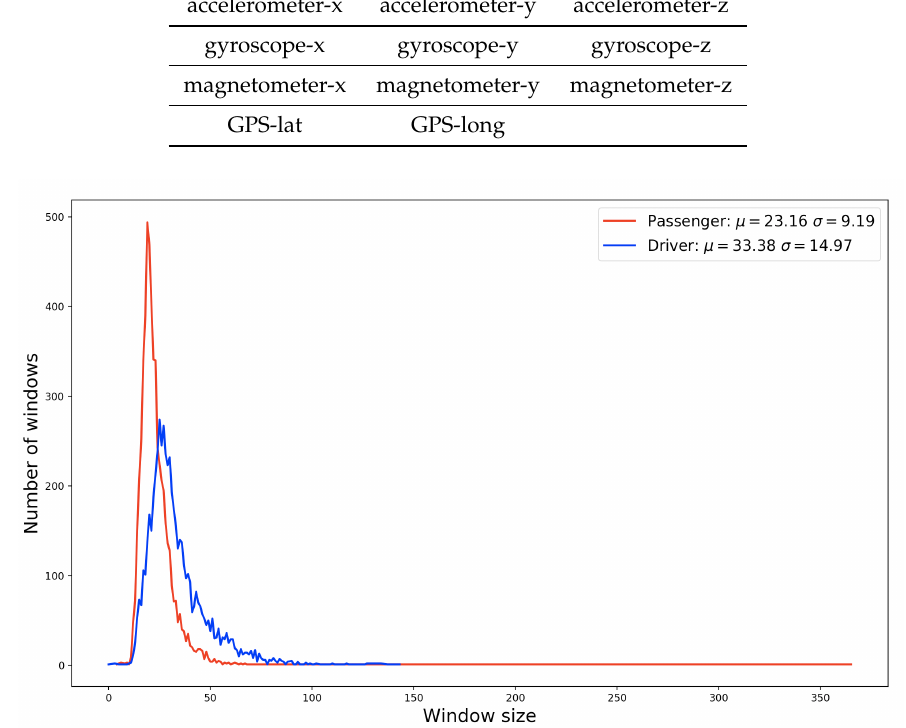
Figure 4. Distribution of windows size collected by users. Each data window represents the interval that the user took to press the begin/end buttons of the